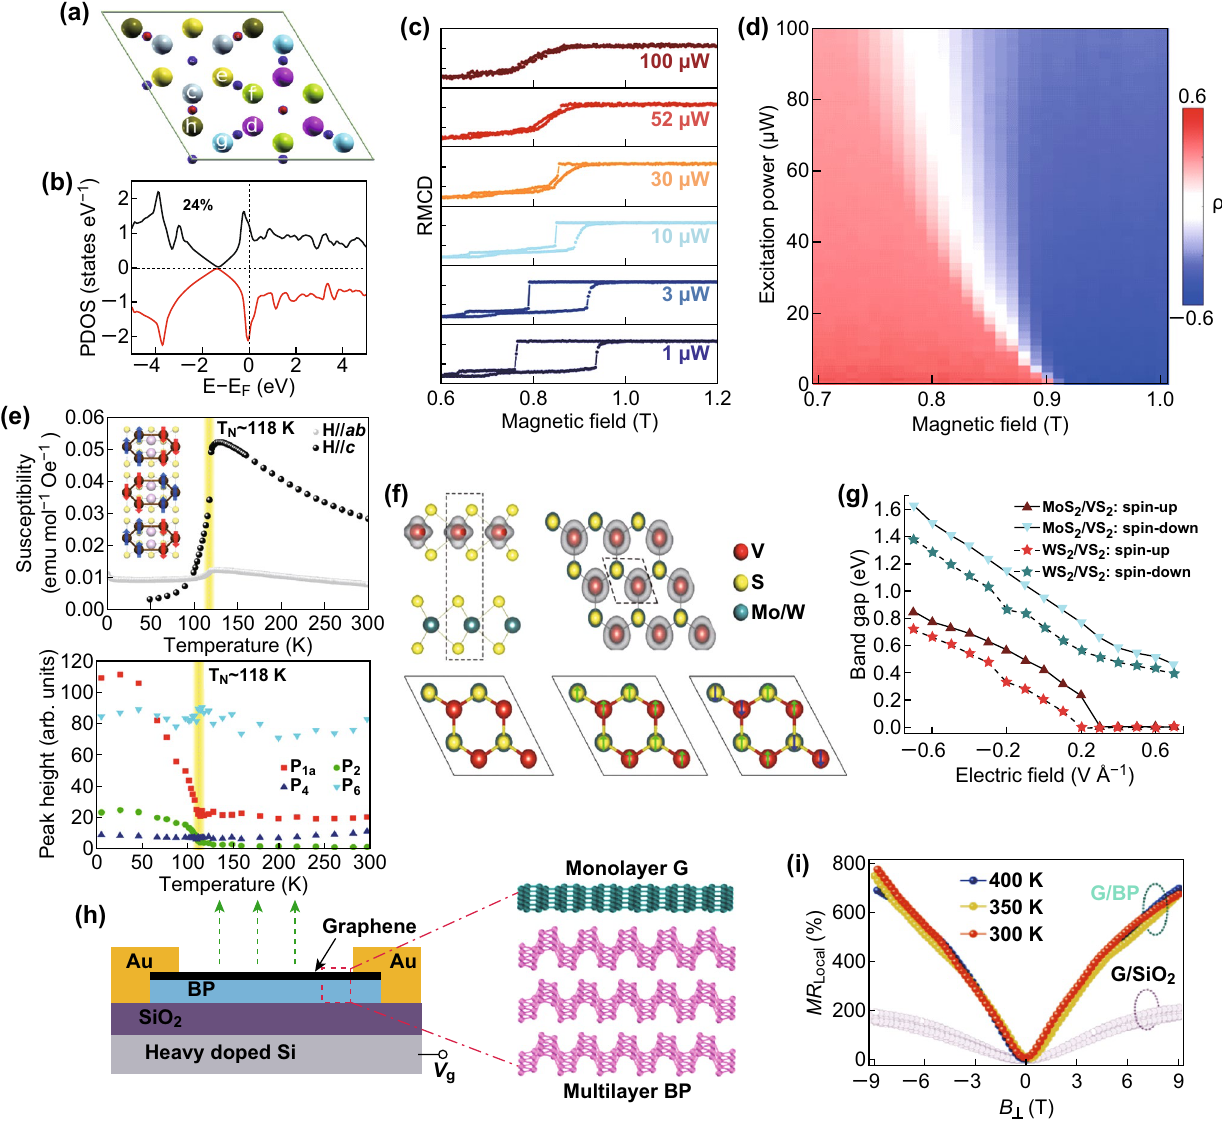
Fig. 7 Magnetic properties of 2D heterostructures. The broken lattice with six sublattices of graphene on the EuO (a) and the calculated spin polarization in graphene layer ( b ). Reprinted with permission from Ref. [74]. The RMCD ( c ) and polarization ρ ( d ) of WSe 2 /CrI 3 heterostructure under sweeping external magnetic field and different excitation power. Reprinted with permission from Ref. [75]. e The transition of several PL peaks and the magnetic susceptibility along the out‑of‑plane direction (black) in FePS 3 as the temperature increases. Reprinted with permission from Ref. [77]. The spin density and possible magnetic ground state (NM, FM, AFM) of XS 2 /VS 2 heterostructures ( f ) and the dependence of band gap ( g ) and electrical field, and the calculated magnetic moment and relative energy is listed in the picture. Reprinted with permission from Ref. [78]. Schematic diagram of the device based on graphene/multilayer BP heterostructure ( h ) and the huge MR ( i ) compared with graphene on SiO 2 substrate. Reprinted with permission from Ref.